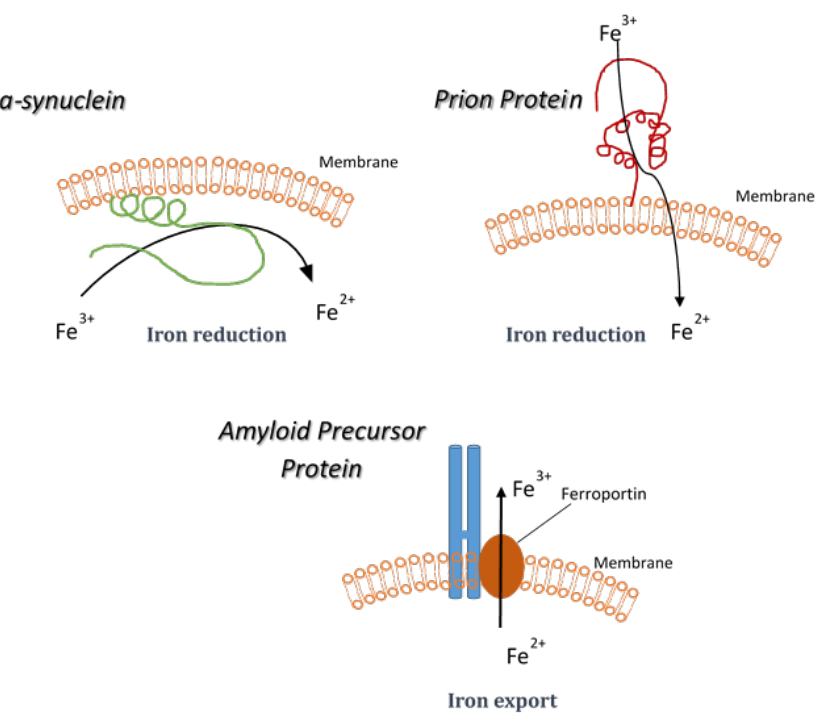
Figure 1. Several of the key proteins associated with neurodegeneration have been suggested to have roles associated with iron. This figure summaries these suggestions. α-synuclein is associated with PD and has been shown to bind iron and reduce it, thus converting Fe 3+ to Fe 2+ which is utilized for many cellular activities. α-synuclein, like most ferrireductases, is associated with the inner face of the cell membrane. There have also been reports that the prion protein, associated with diseases like CJD, can also act to reduce iron as a ferrireductase. Lastly, the amyloid precursor protein (APP) the precursor to beta-amyloid known from AD, has been shown to enhance iron export out of cells. This process requires the presence of ferroportin, which mediates the iron export